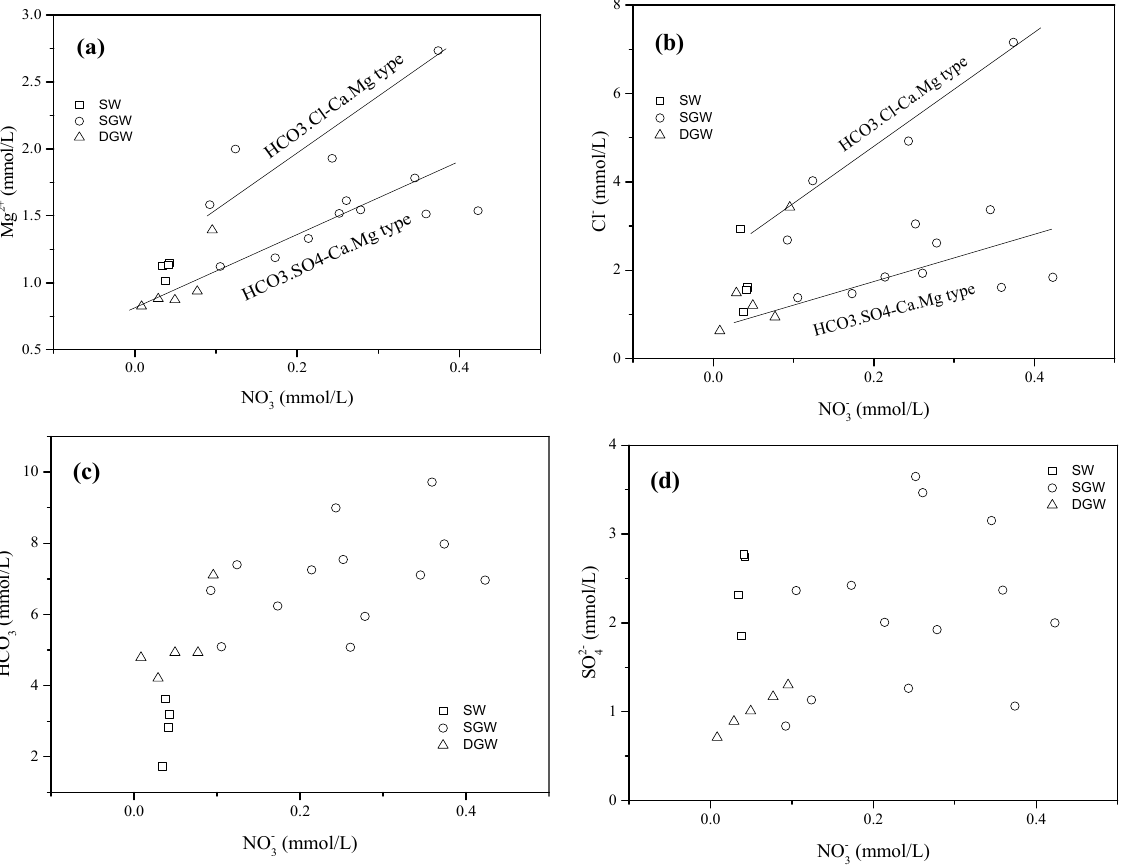
Figure 5. Concentrations of cation (Mg 2+ ) and anions (Cl − , HCO (cid:2871)(cid:2879) and SO (cid:2872)(cid:2870)(cid:2879) ) vs. that of NO (cid:2871)(cid:2879) concentrations in surface water and groundwater: ( a ) Mg 2+ vs. NO (cid:2871)(cid:2879) ; ( b ) Cl − vs. NO (cid:2871)(cid:2879) ; ( c ) HCO (cid:2871)(cid:2879) vs. NO (cid:2871)(cid:2879) ; ( d ) SO (cid:2872)(cid:2870)(cid:2879) vs. NO (cid:2871)(cid:2879) . (SW: Surface water; SGW: Shallow groundwater; DGW: Deep